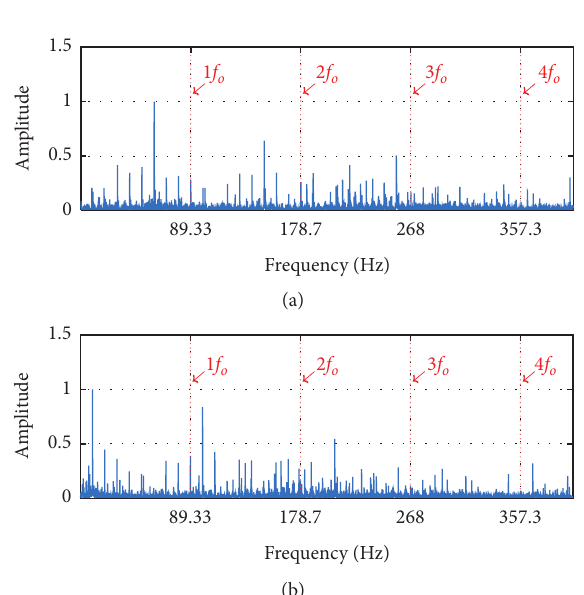
Figure 14: Results of the combined method using traditional wavelet threshold and Fast-SC. (a) Soft wavelet threshold and Fast-SC. (b) Hard wavelet threshold and Fast-SC.